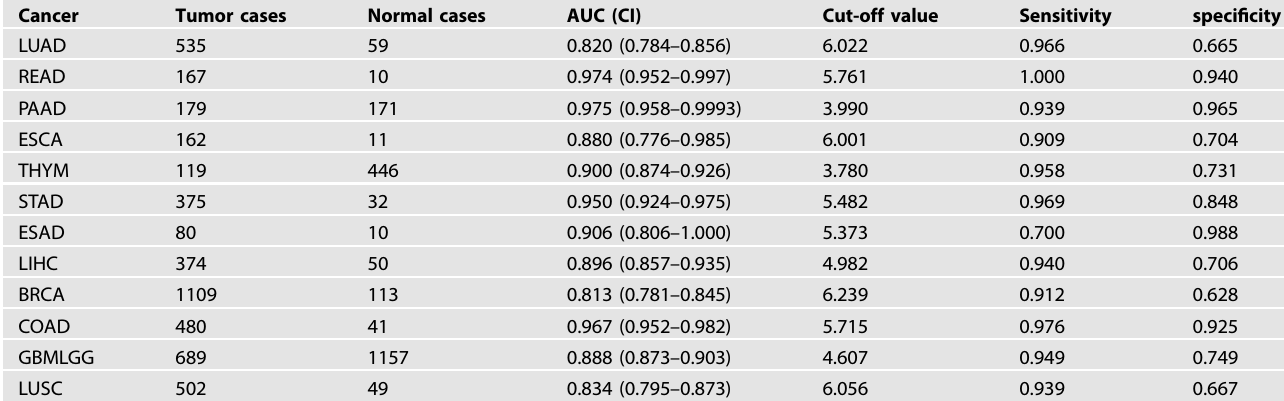
Table 2. Diagnostic value of YTHDF1 in